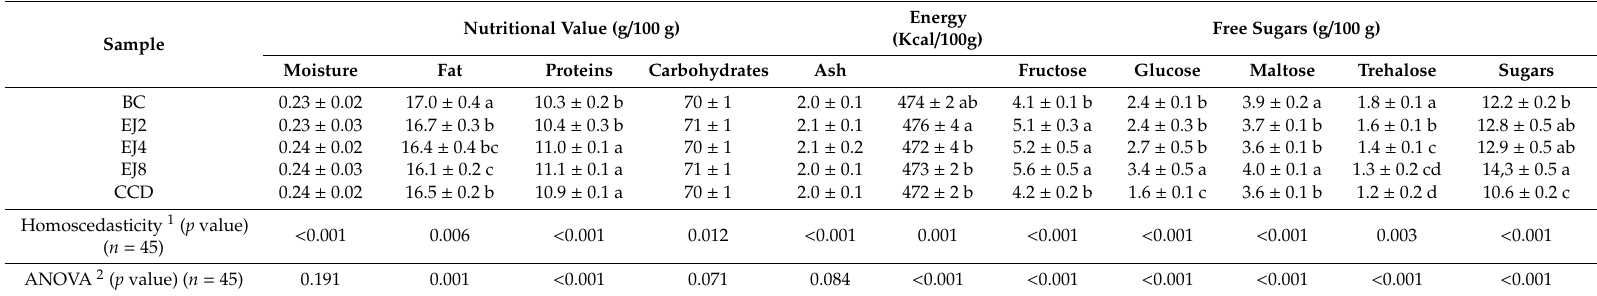
Table 2. Nutritional value and free sugars identified in the di ff erent croissant formulations.